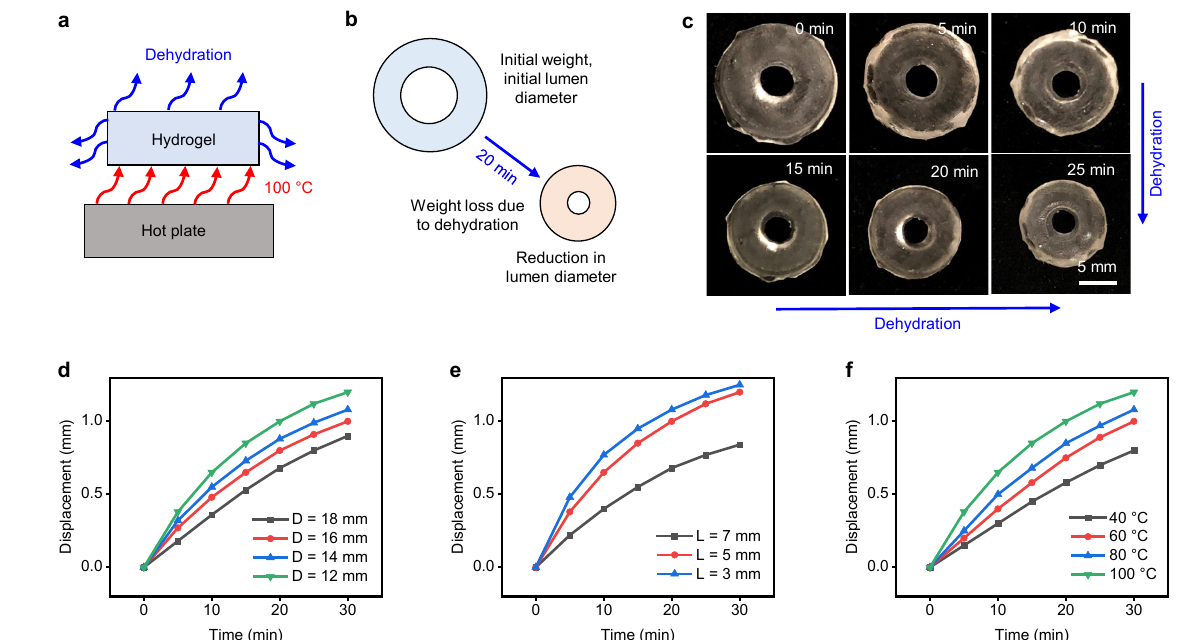
Figure 6. PAHV thermo-mechanical performance. Schematic showing the PAHV’s ( a ) experimental set-up, ( b ) de-swelling actuation mechanism. ( c ) Time-lapse images exhibiting the PAHV’s actuation dynamics ( D = 12 mm, L = 5 mm) when heated at 100 ◦ C. ( d ) Displacement in PAHVs ( L = 5 mm) of different diameters (12–18 mm) when actuated at 100 ◦ C. ( e ) PAHV displacement ( D = 12 mm) for different lengths (3–7 mm) when actuated at 100 ◦ C. ( f ) PAHV displacement ( D = 12 mm, L = 5 mm) when actuated at different temperatures (40–100 ◦